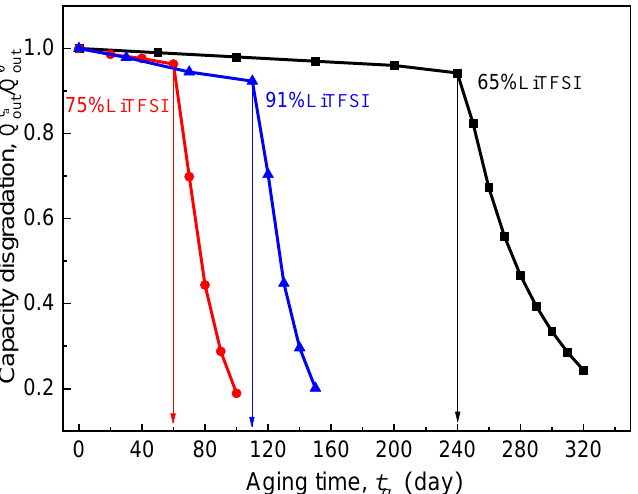
Figure 10. Effect of lithium salt content of SPE on electrolyte-aging induced capacity degradation.